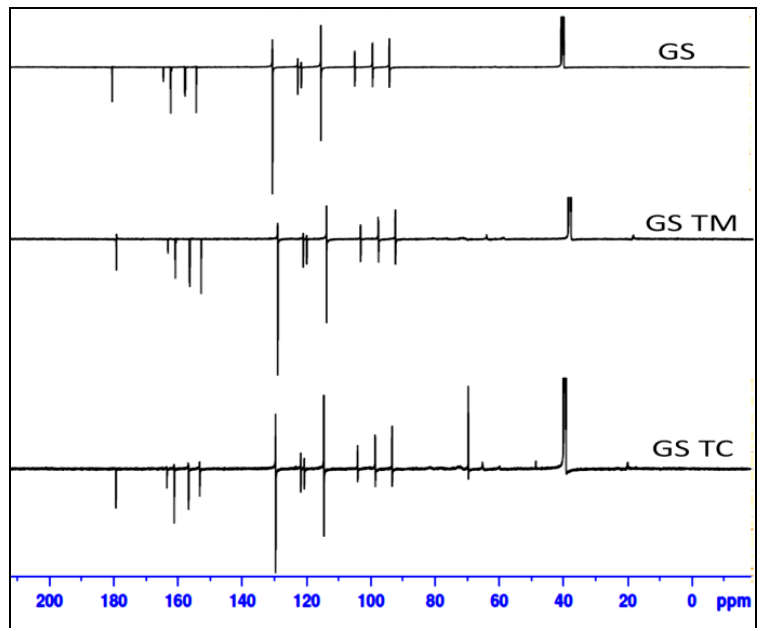
Figure 8. NMR spectra of pure Genistein (GS), genistein ternary mixture (GS-TM) and genistein ternary complex (GS-TC).